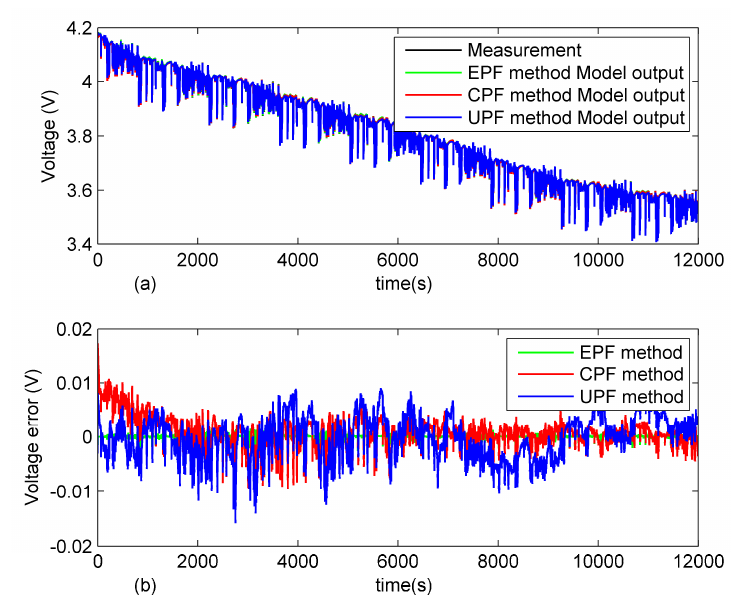
Figure 5. Comparison of SOC estimation accuracy under the City test: ( a ) SOC estimation; and ( b ) SOC estimation error.